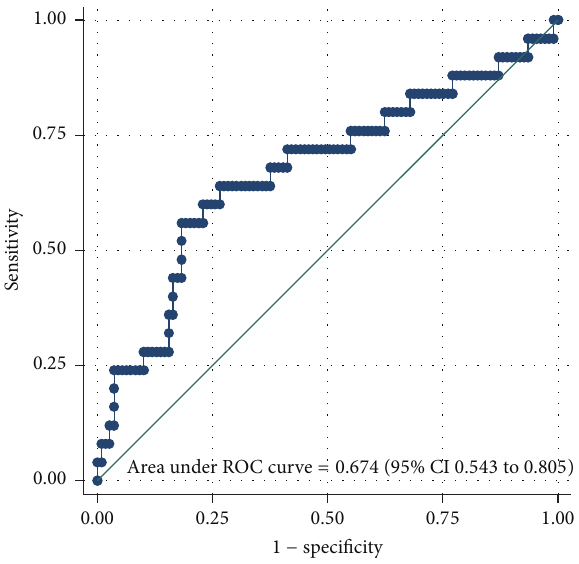
Figure 2: Receiver operating characteristic curve.